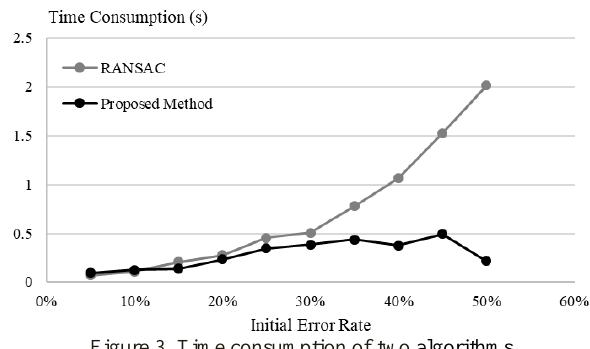
Figure 3. Time consumption of two